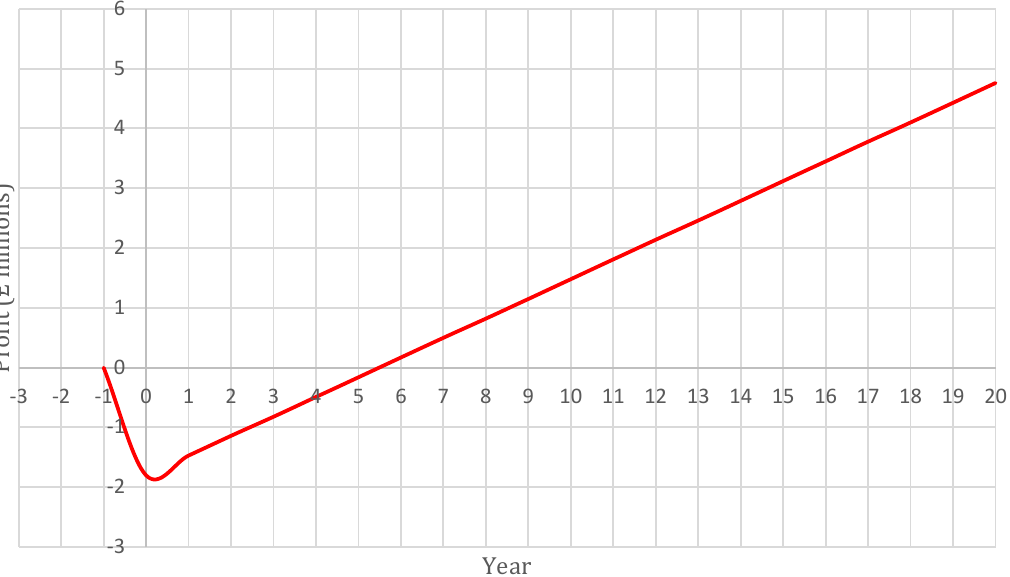
Figure 4. Cumulative cash flow graph for conversion process of HDPE to pyrolysis oils at a feed rate of 100 kg/h and a sale price of £300/barrel.